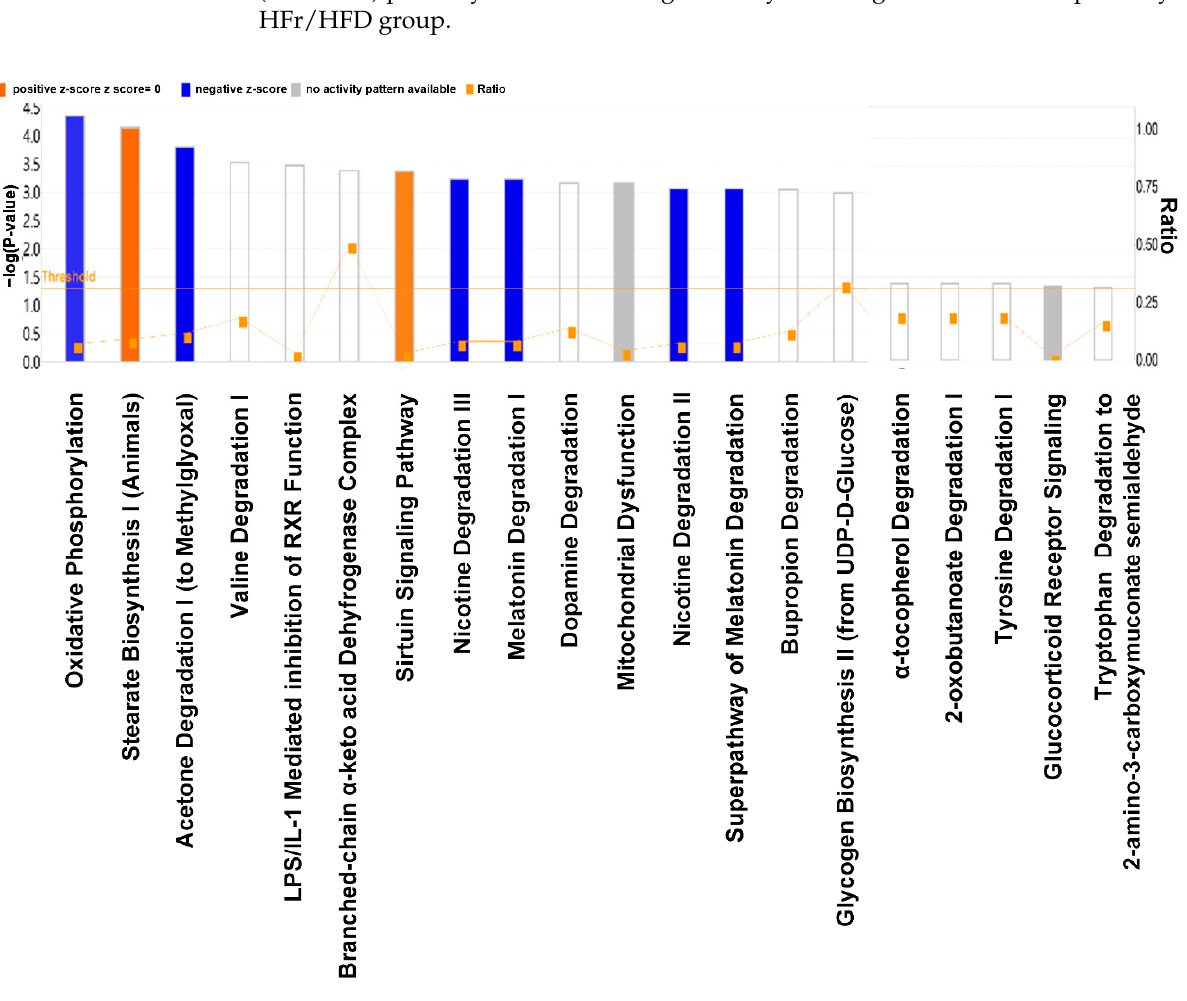
Figure 5. A comparison of the canonical pathways in the liver between the HFD and HFr/HFD groups using Ingenuity Pathway Analysis. An analysis of the pathway is depicted horizontally, and the unadjusted p -value is shown vertically ( − log( p )). Expressions of canonical pathways are considered to be significantly different between these two groups at a p ≤ 0.05, with the threshold set to 1.3. Orange indicates pathway upregulation and blue indicates pathway downregulation in the HFr/HFD group, compared with the HFD group. A gray bar indicates that there can be no prediction. HFD: high-fat diet group. HFr/HFD: high-fat diet plus 30% fructose in drinking water group.